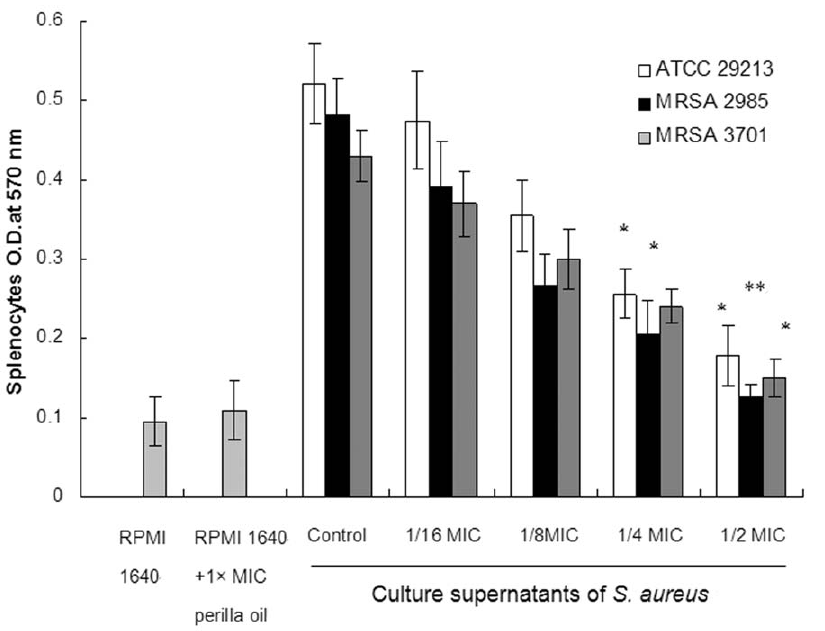
Figure 2. Induction of murine splenocyte proliferation by S.aureus supernatants. S. aureus strains were cultured with graded subinhibitory concentrations of perilla oil in RPMI 1640. Values represent the mean 6 SD for three independent experiments. * represents p , 0.05 and ** represents p , 0.01. doi:10.1371/journal.pone.0016160.g002 PLoS ONE |